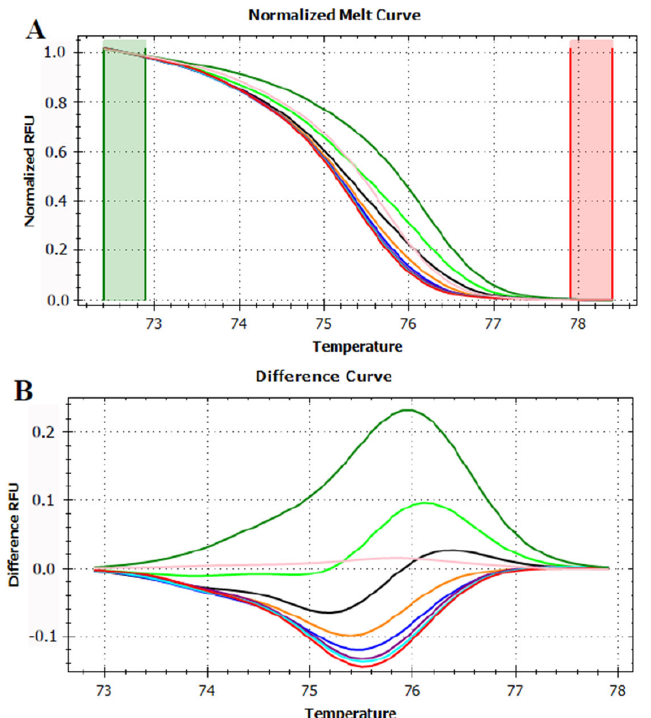
Figure 7. Normalized melt curve ( A ) and difference curve ( B ) of HRMA of P6 loop of trnL (UAA) intron on DNA blends of apple and kiwi. Apple fruit: red, kiwi fruit: green, apple/kiwi DNA mixes 99.5%/0.5%: light blue, 99%/1%: purple, 95%/5%: blue, 90%/10%: orange, 75%/25%: black and 50%/50%: light green. Reference cluster is peach fruit: pink. The HRMA has been carried out on three independent replicates of each sample and the most representative curve of each sample is reported in the graph.